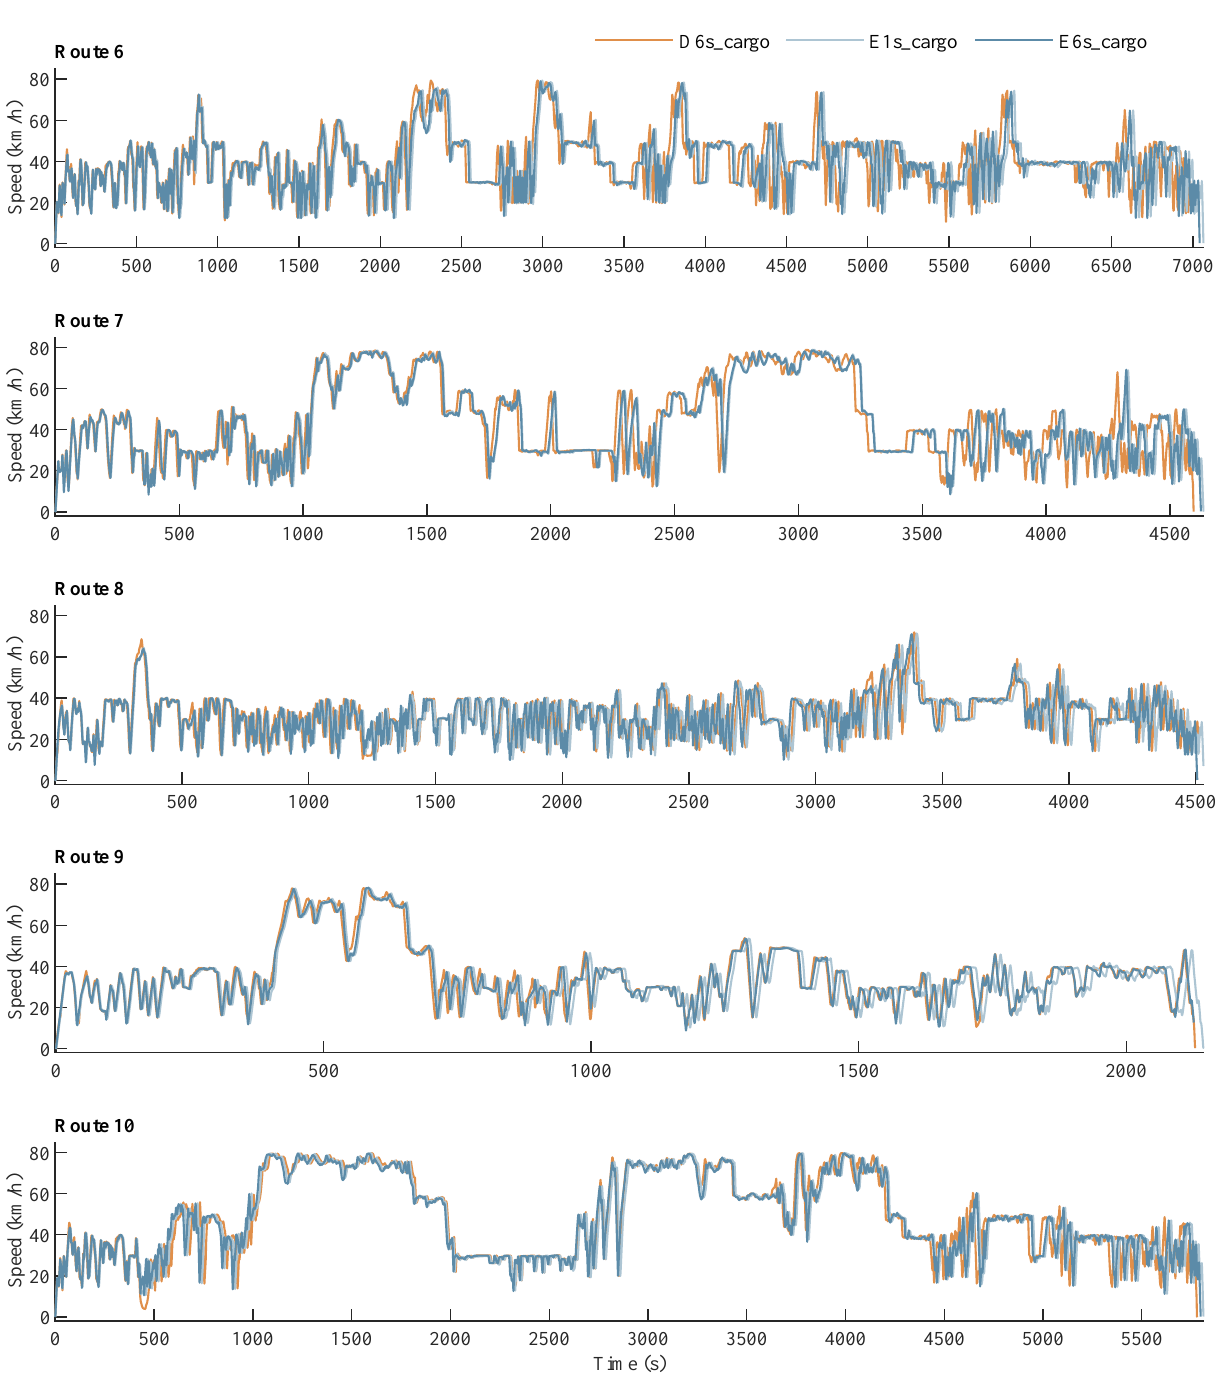
Figure A2. Speed performance with the cargo load on routes